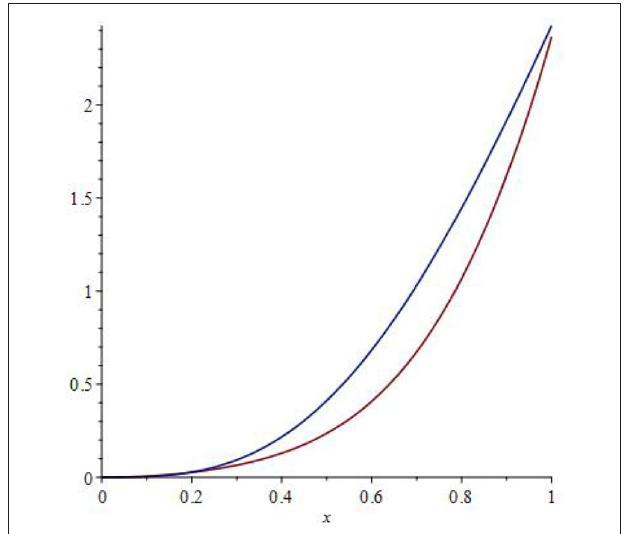
FIGURE 1 | The graphs of Equations 9 (magenta) and 10 (blue) with some plausible